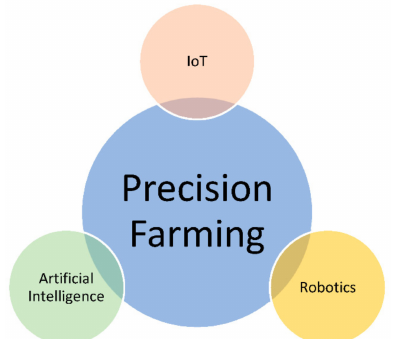
Figure 1. Three foundation technologies of precision